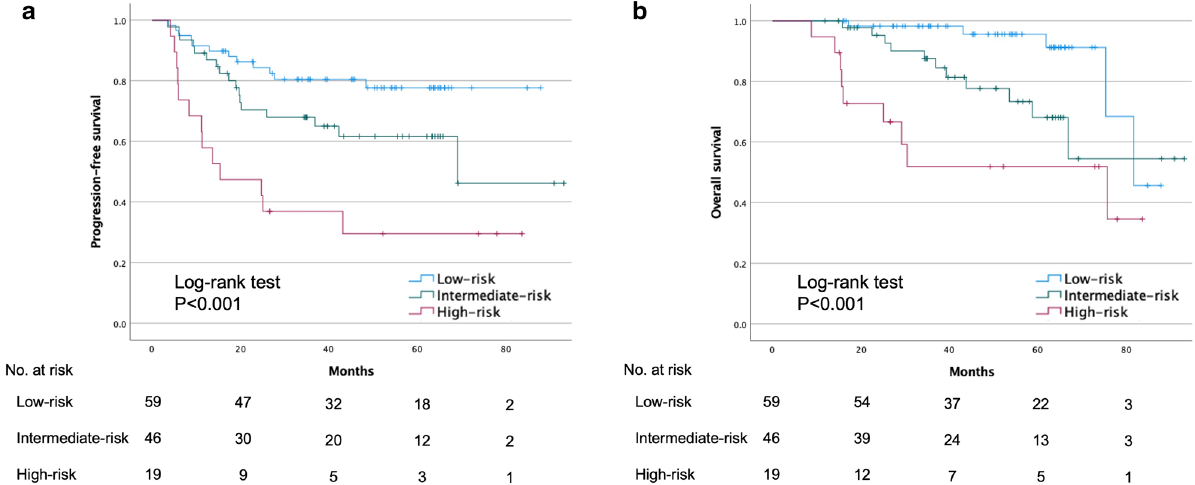
Figure 3. Progression-free survival (PFS) and overall survival (OS) according to the pre-CAR and post-PNI.